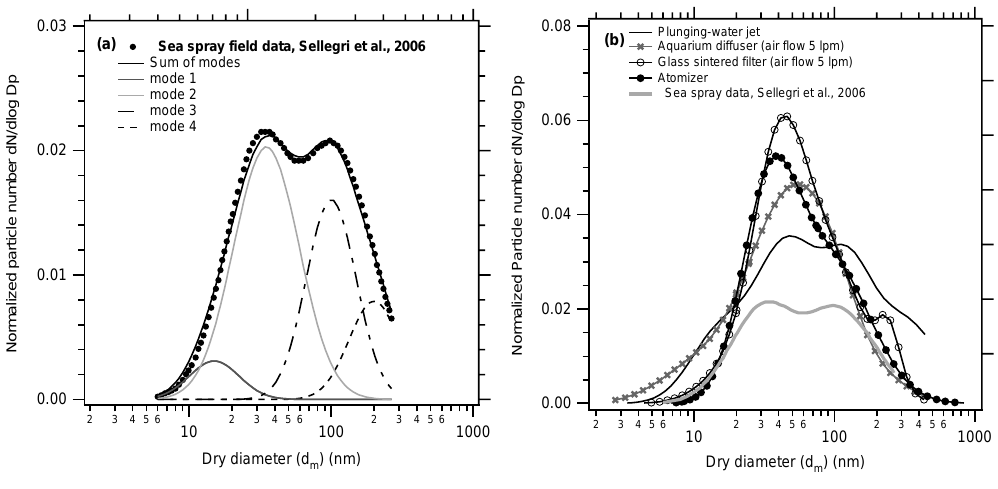
Fig. 7. (a) Normalized atmospheric sea spray size distribution from Sellegri et al. (2006) and (b) comparison of primary particle size distributions of aerosols generated from artificial sea water via bubble-bursting and atomization (shape factor χ =1.04) and the atmospheric size distribution from Sellegri et al.